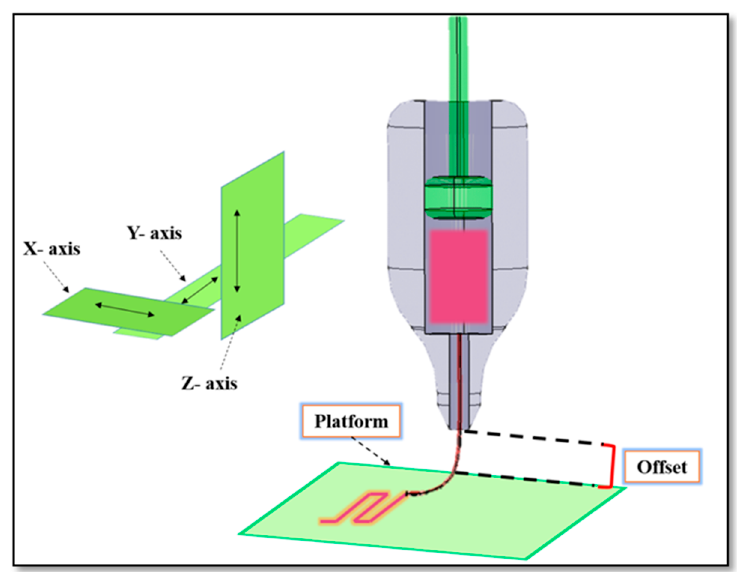
Figure 1. The schematic diagram of an extrusion-based 3D bio-printer.